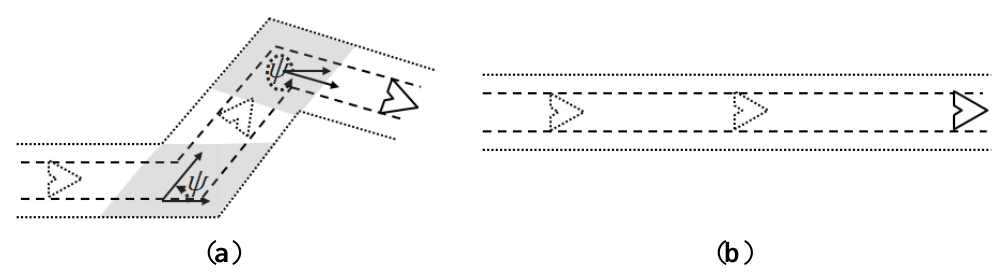
Figure 14. Area covered by a trail: ( a ) with overlap (parts colored in gray); ( b ) without